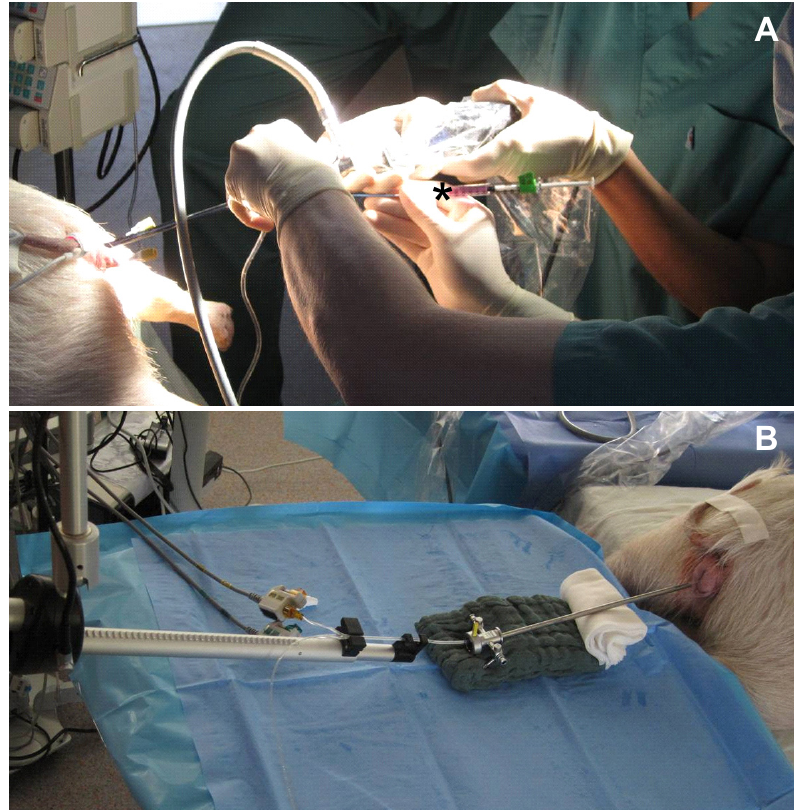
Figure 4 . Cell application and functional read-out . ( A ) Transurethral injection of cells during cystoscopy procedure under visual control. Defined volumes of labeled cell suspension can be applied via a syringe (asterisk) and needle; ( B ) Urethral pressure profiles (UPP) can continuously be measured by a balloon catheter automatically retracted from the bladder to the rhabdosphincter and